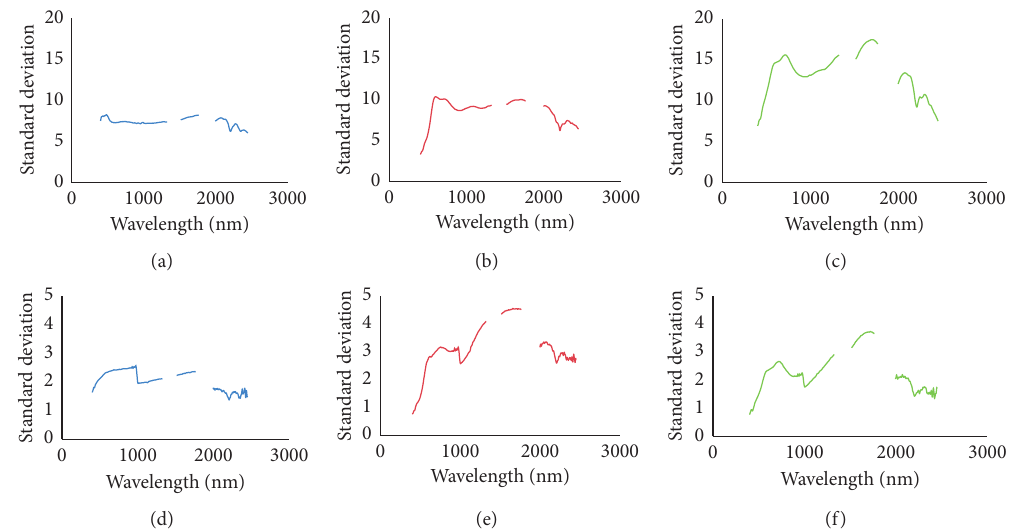
Figure 4: The spectral standard deviation calculated using the laboratory measurements (a–c) for M1-M3, respectively, and using the field measurements (d–f) for M1-M3,